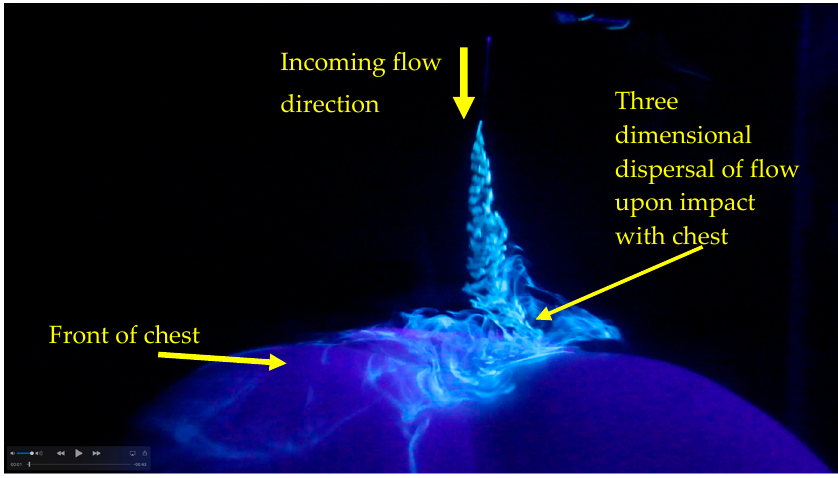
Figure 5. Screen shot of video of fluorescent dye flow visualization over the chest of a mannequin. Note the three dimensional dispersion of the flow as its velocity is reduced upon impact with the